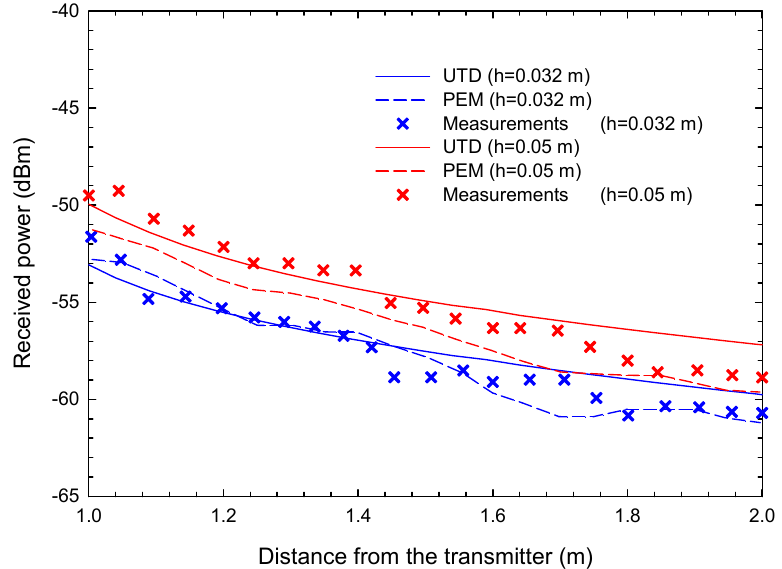
Figure 29. Comparison between the theoretical GO/UTD results for the LOS case (two obstacles) and the measurements presented in [8].